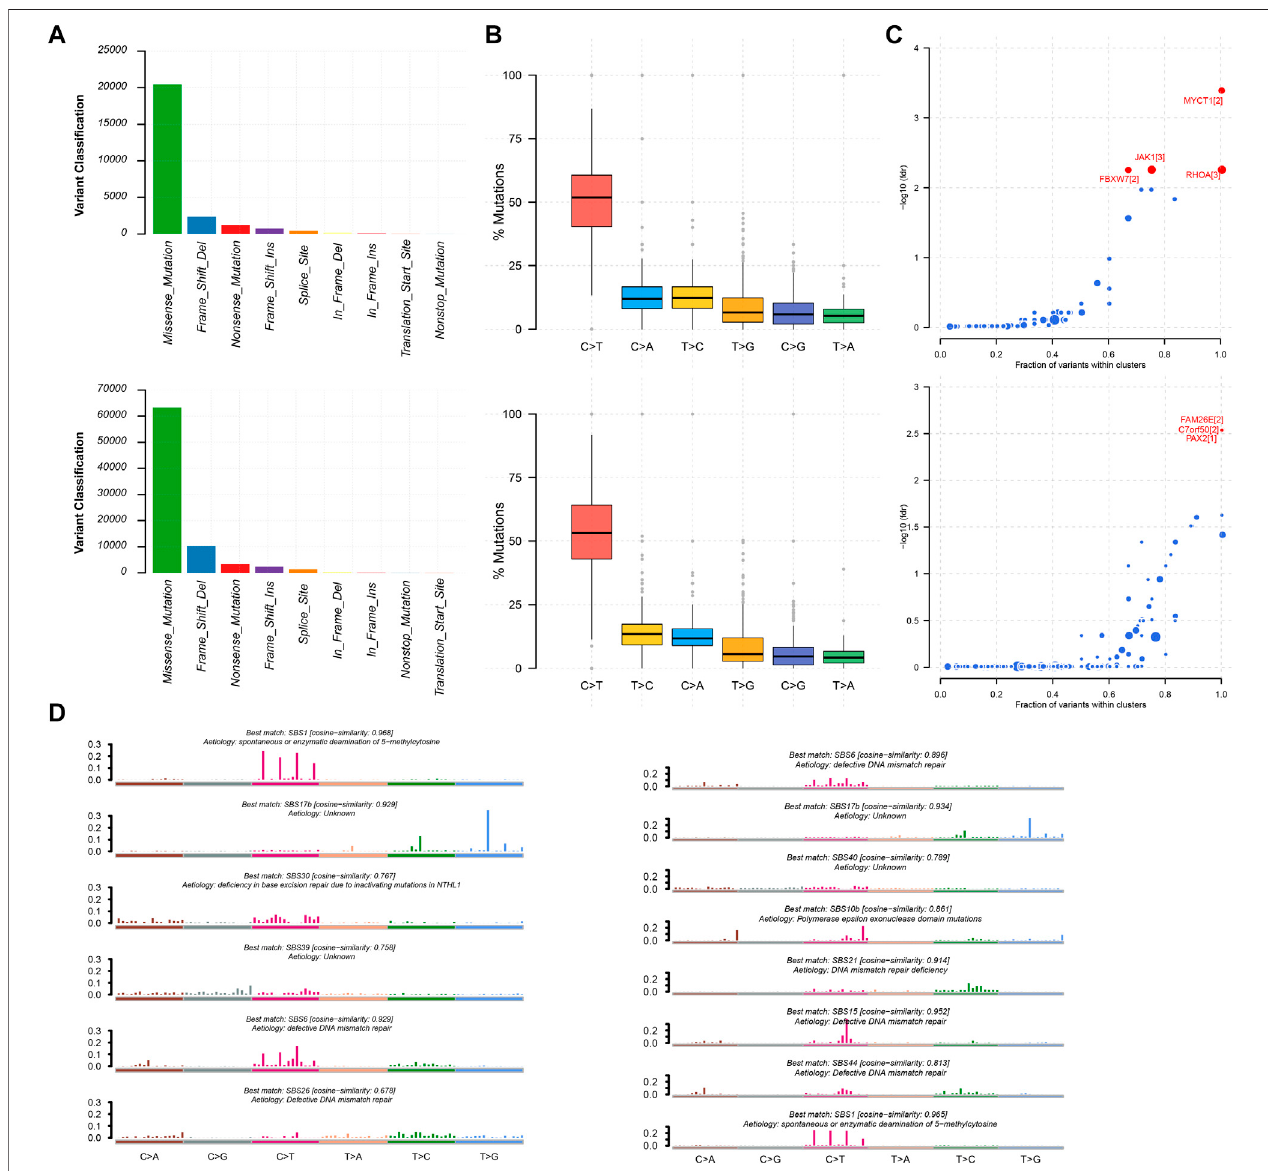
FIGURE5| Mutationinformationofhigh-risksamplesandlow-risksamples. (A,B) Statisticofvariantclassi fi cation andmutationtypeofsampleswithhigh-risk(top panel) and low-risk (bottom panel) survival. (C) Driver mutation genes in high-risk and low-risk samples (top and bottom panel respectively). (D) Mutational signatures were identi fi ed in high-risk and low-risk samples, respectively. The plot title indicates the best match against validated COSMIC signatures (left and right panel respectively).